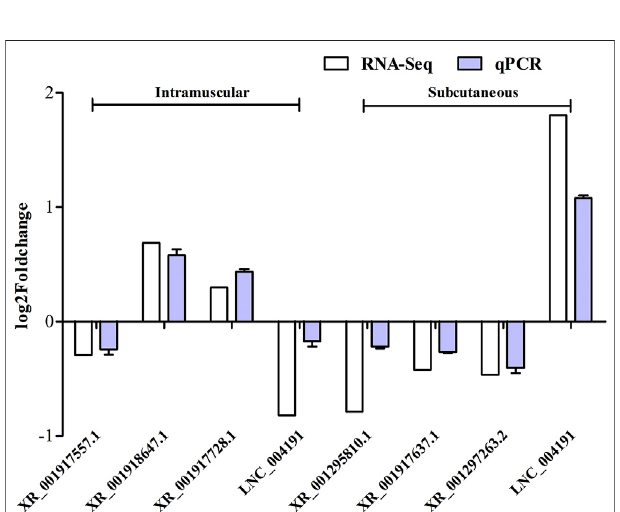
FIGURE 7 | Validation of lncRNAs in intramuscular and subcutaneous adipocytes using RT-qPCR technique. Data were analyzed by the 2 − ΔΔ Ct method where the UXT was used as a reference gene. Each column represents the mean ± SE. White bars represent read from RNA-Seq, and blue bars represent the results from qRT-PCR